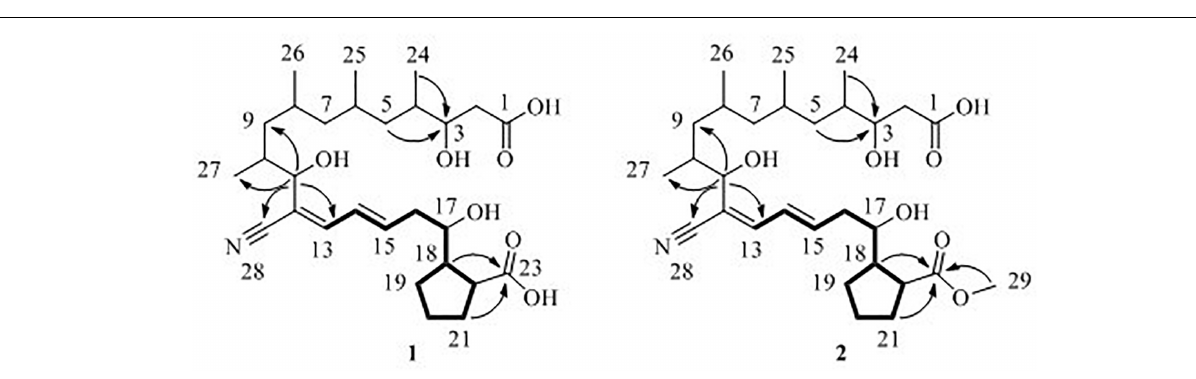
FIGURE 3 | HR-ESI-MS of the EtOAc extracts (positive ion mode) of pure culture of R . similis 35.